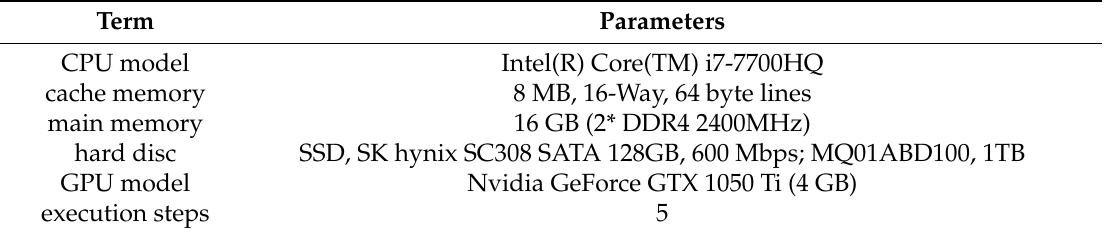
Table 2. Parameters the computer